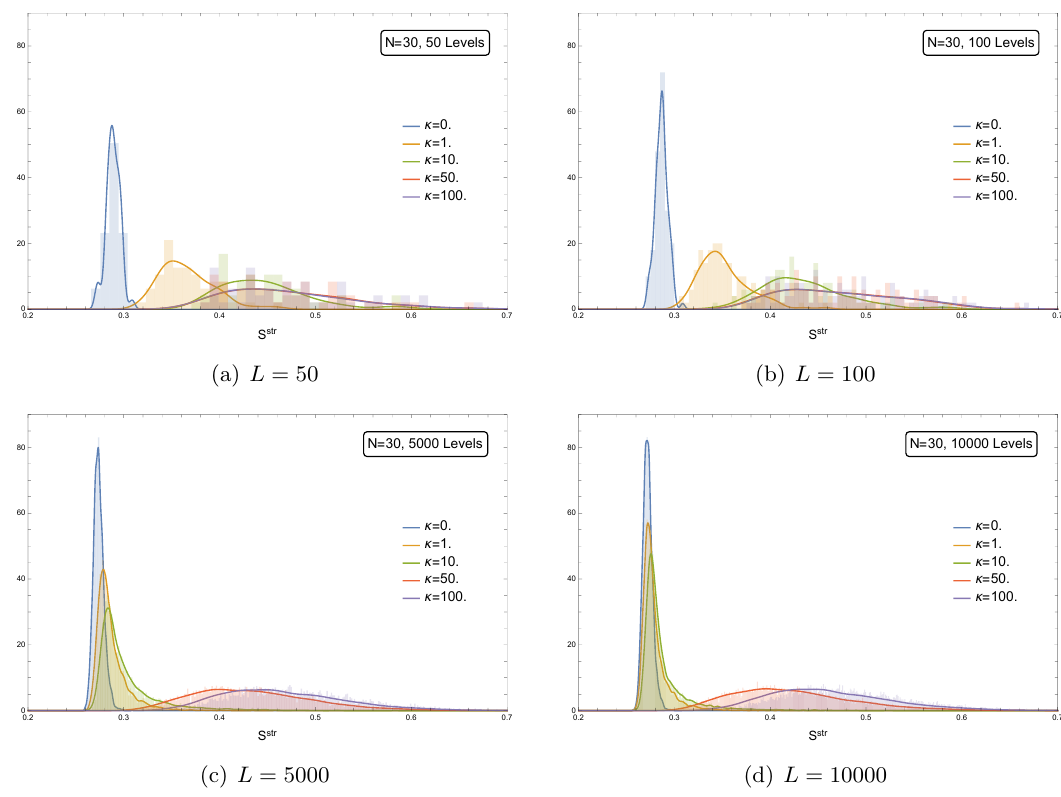
Figure 15 . The distribution of the structural entropy of the subsectors of the spectra including L levels starting from the ground state of the even parity sector ( D = 2 14 ) of N = 30 SYK model with (cid:20) = 0 ; 1 ; 10 ; 50 ; 100 ( L = 50 ; 100 ; 5000 ; 10000).